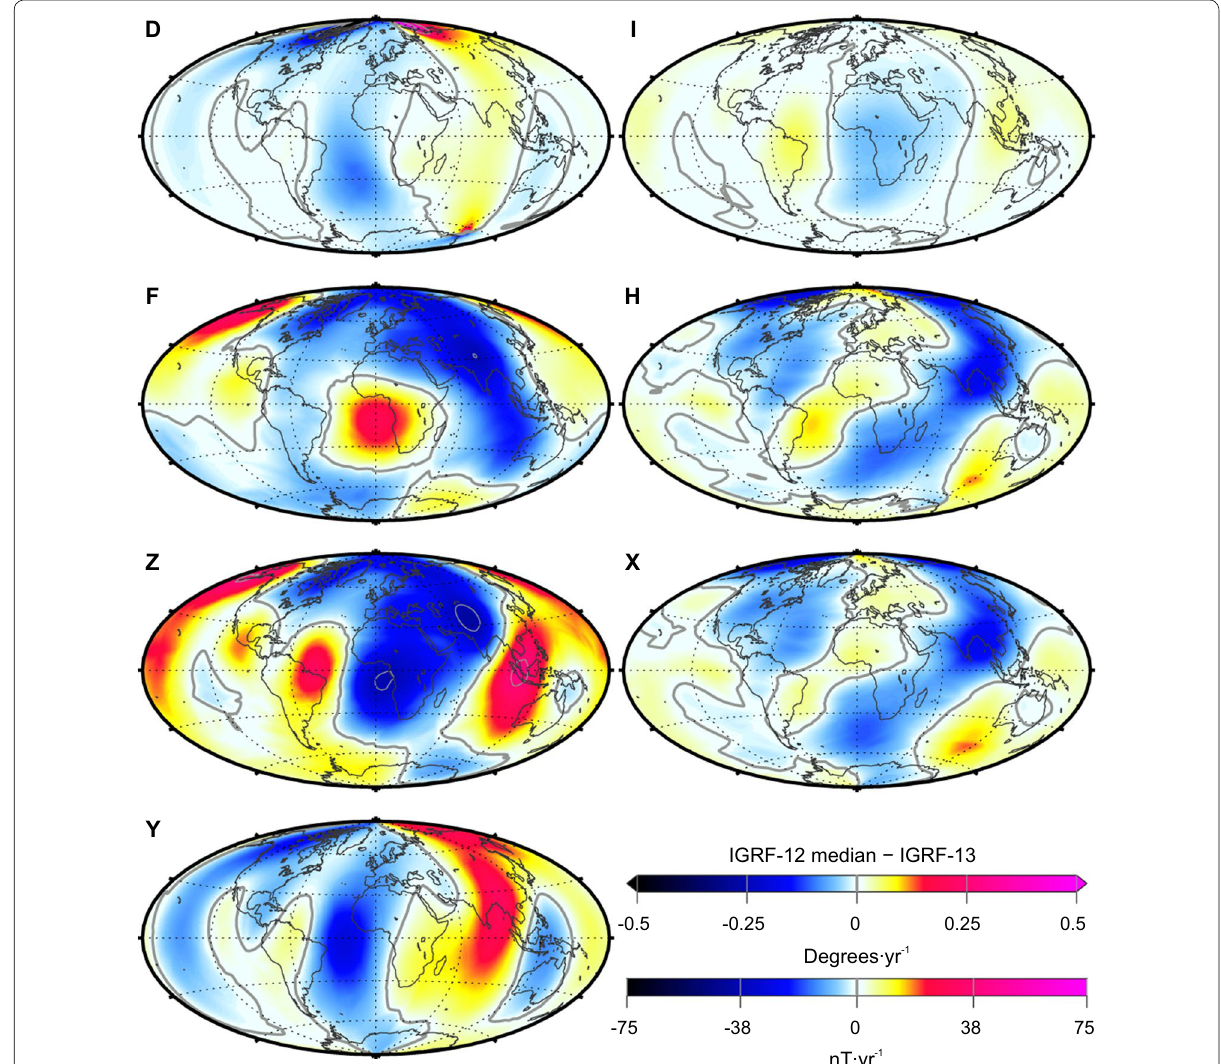
Fig. 9 Spatial median for each component of field differences between all IGRF-12 SV candidates and IGRF-13 SV for 2015–2020. Values of contours (grey lines) are marked on the colour scales, with a thicker line for the zero